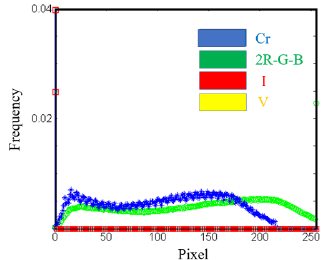
Figure 8. Histogram comparison of Y, V, I, and 2R-G-B.